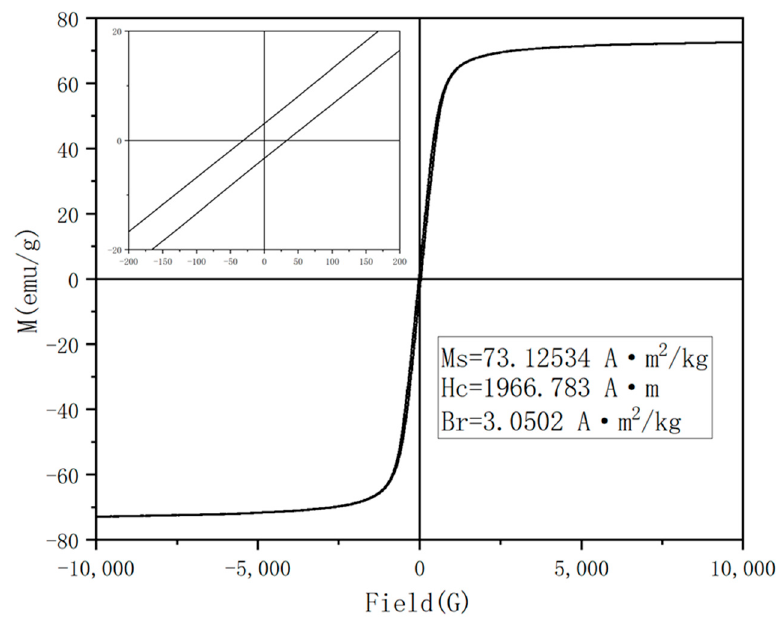
Figure 9. Hysteresis loop diagram of Fe 3 O 4 nanoparticles.